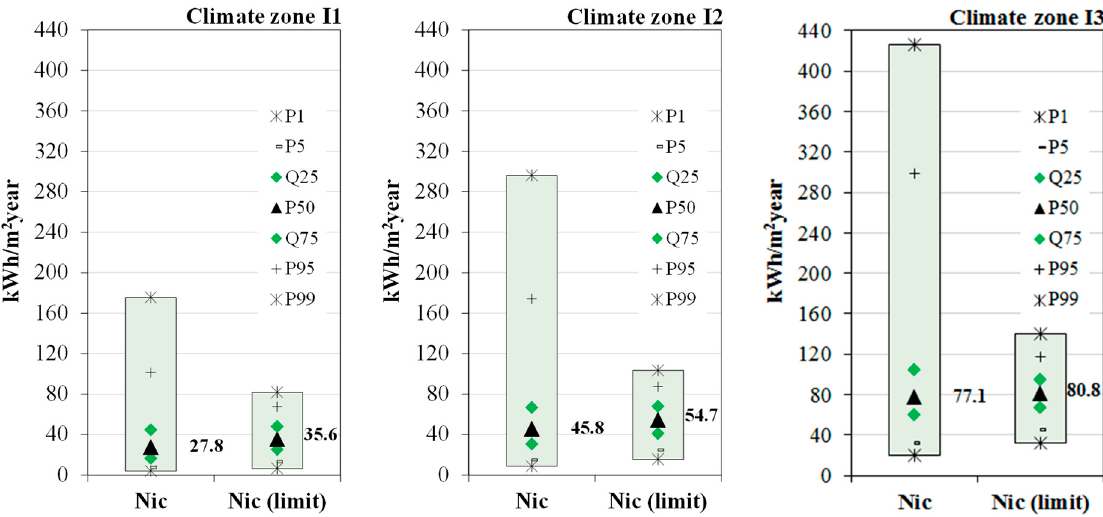
Figure 6. Nominal primary energy needs for the three Portuguese climatic zones in winter.